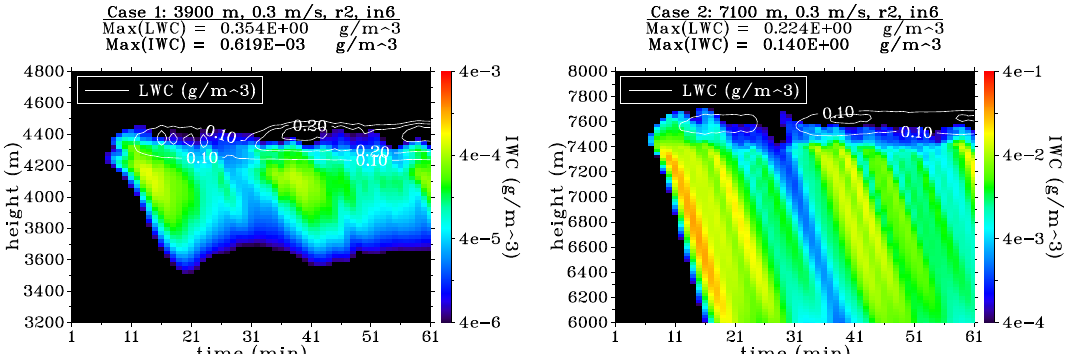
Figure 17. LWC (colors) and IWC (contours, logarithmic scale) for case 1 (W_in6, left) and case 2 (C_in6, right). Enhancing IN by increasing N AP ,r> 250nm by a factor of